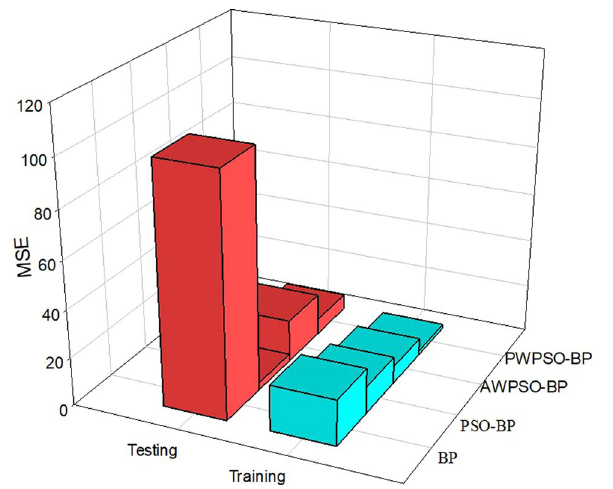
Figure 20. MSE comparison diagram of the right